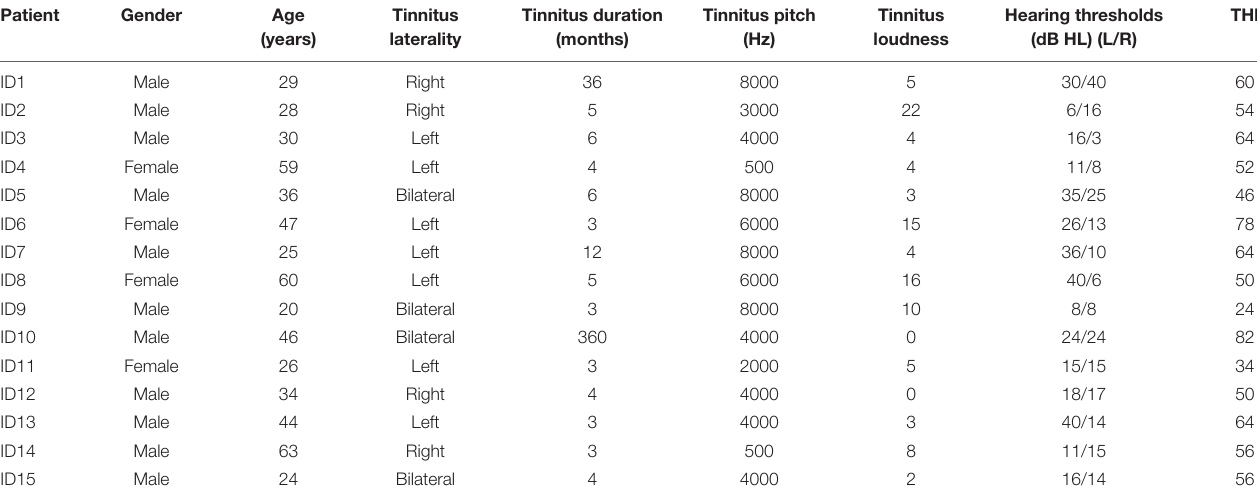
TABLE 1 | The landscape layout of participants with